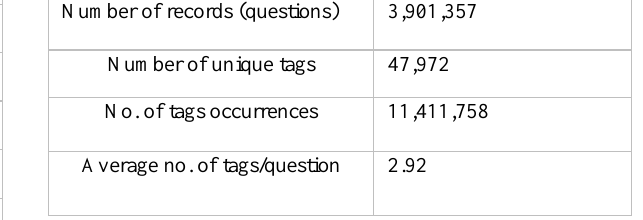
Table 3. Statistical of raw data, time between (2018 and